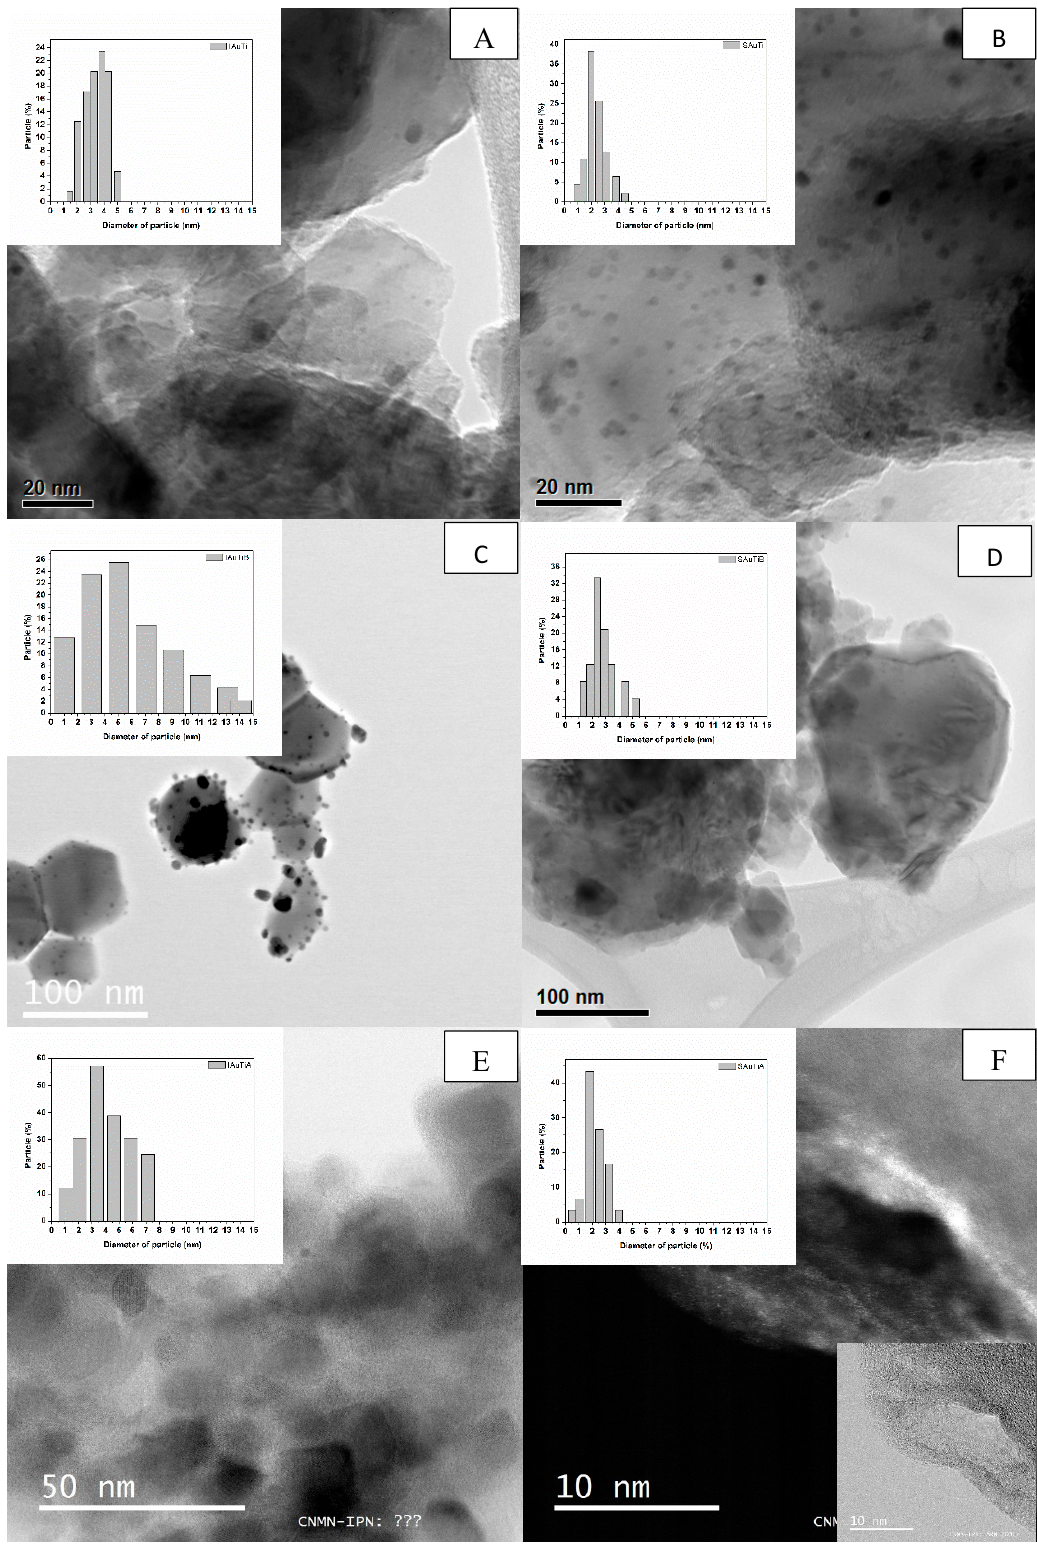
Figure 5. TEM images of the samples synthesized without pH modification by the IiM and SiM, ( A , B ), respectively. TEM images of the samples synthesized in basic pH by the IiM and SiM, ( C , D ), respectively. Samples synthesized in acid pH by the IiM and SiM, ( E , F ), respectively.